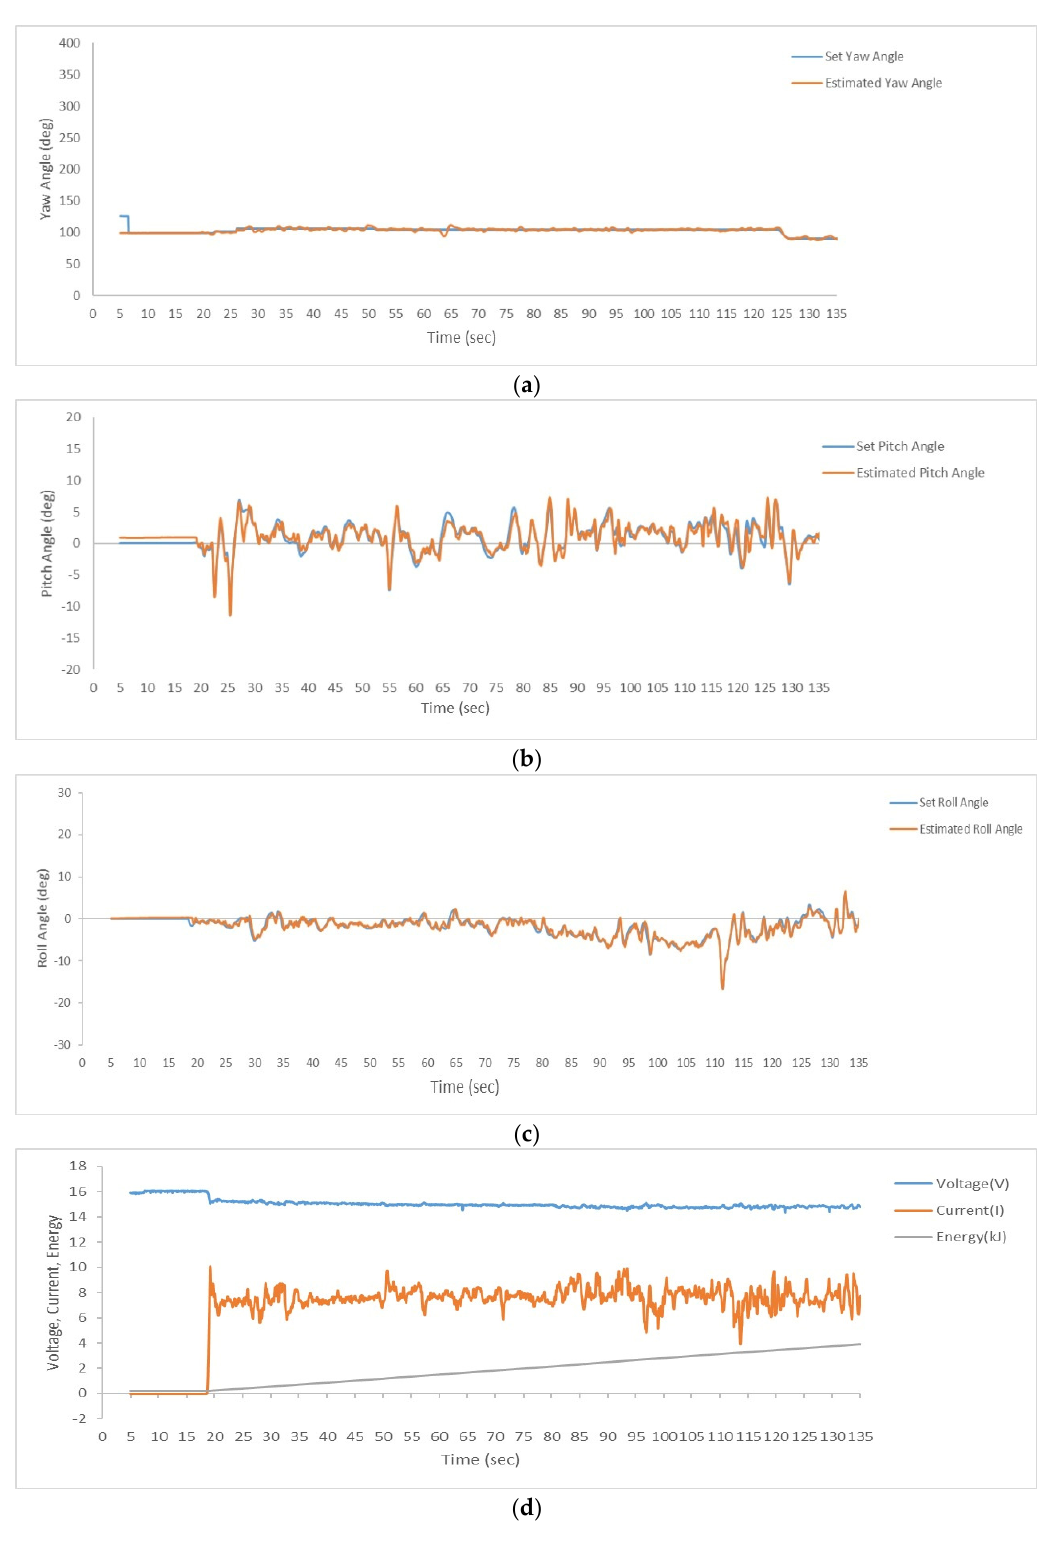
Figure 31. Field test results. ( a ) Stability during Yaw, ( b ) Stability during Pitch, ( c ) Stability during Roll, ( d ) Power consumption vs time. Roll, ( d ) Power consumption vs